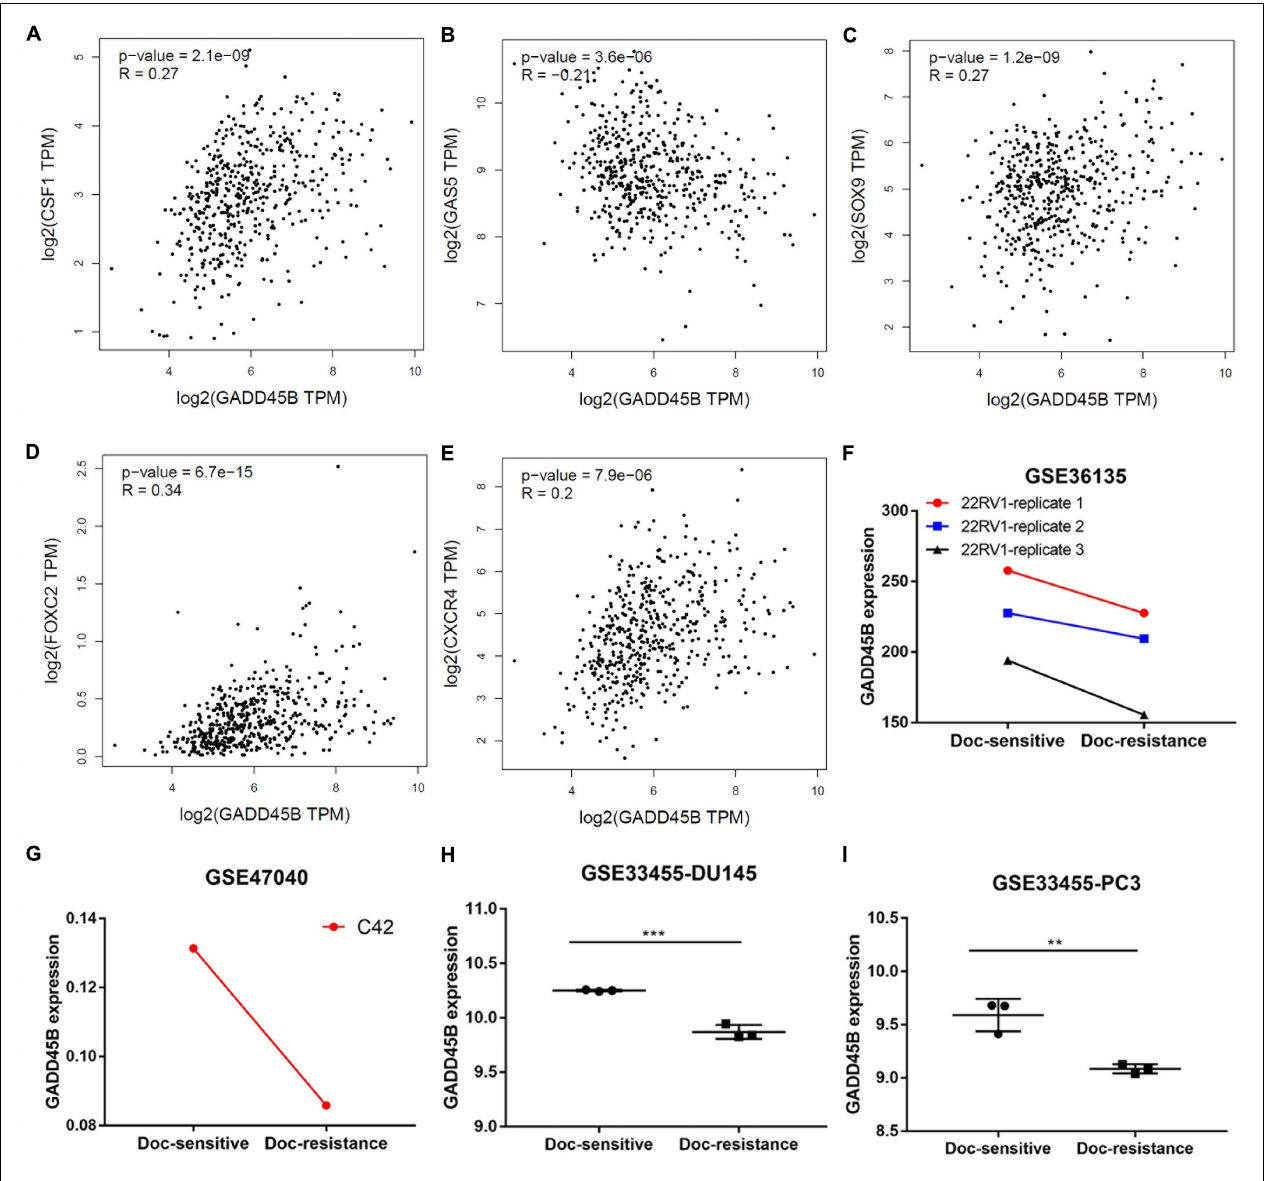
FIGURE 4 | GADD45B was correlated to chemotherapy sensitivity–related genes and lowly expressed in docetaxel-resistant PCa cell lines. (A–E) The correlation between GADD45B and the reported chemotherapy sensitivity–related genes: CSF1 (A) , GAS5 (B) , SOX9 (C) , FOXC2 (D) , and CXCR4 (E) . (F–I) GADD45B was lowly expressed in docetaxel-resistant 22RV1 (F) , C42 (G) , DU145 (H) , and PC3 (I) . ** p < 0.01 and *** p <